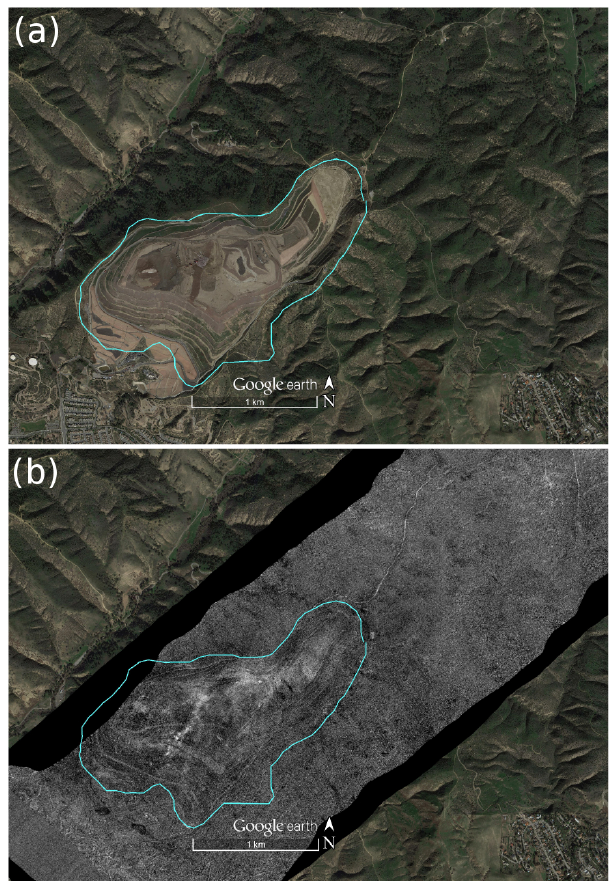
Figure 9. (a) Google Earth map showing the Olinda Alpha Land- fill encircled by the cyan solid line. (b) CH 4 anomaly map derived from AVIRIS-NG data and superimposed on the Google Earth map. Shown is the nearby field around the landfill acquired at around 13:33LT. White pixels correspond to detected CH 4